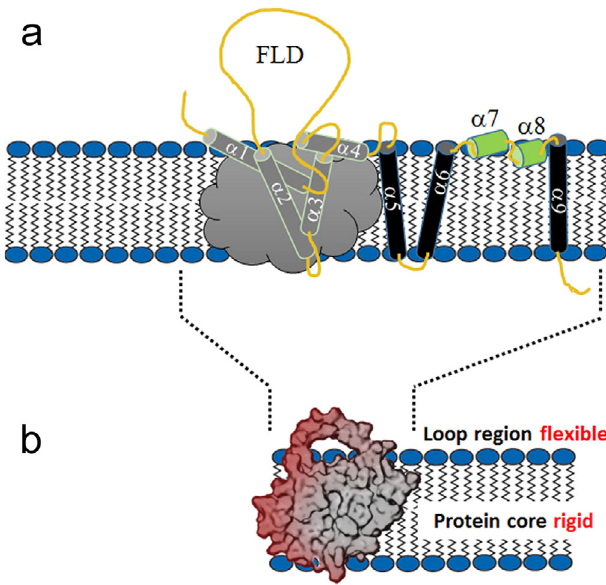
Fig. 5 Schematic diagram of the membrane-embedded location required for Bcl-2 protein ’ s functionality. a Arrangement of helices and loops of full-length human Bcl-2 protein derived from its sequence, structural information from soluble Bcl-2 versions 29,31 , alterations in membrane topology during apoptosis 14 , comparison with the related Bcl-x L protein (which has conformational plasticity ranging from soluble to embedded states 15,19,41 ) and the NR/NMR results reported here. For membrane- inserted α 1 to α 4 helices (gray cloud) no detailed information is available. b Locations of the Bcl-2 main body within the membrane boundaries and solvent-accessible regulatory loop region (FLD) at the membrane surface, observed by NR and NMR, respectively. The main protein body is dynamically restricted while the FLD region is highly fl